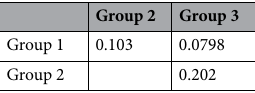
Number of conserved heterozygous sites %